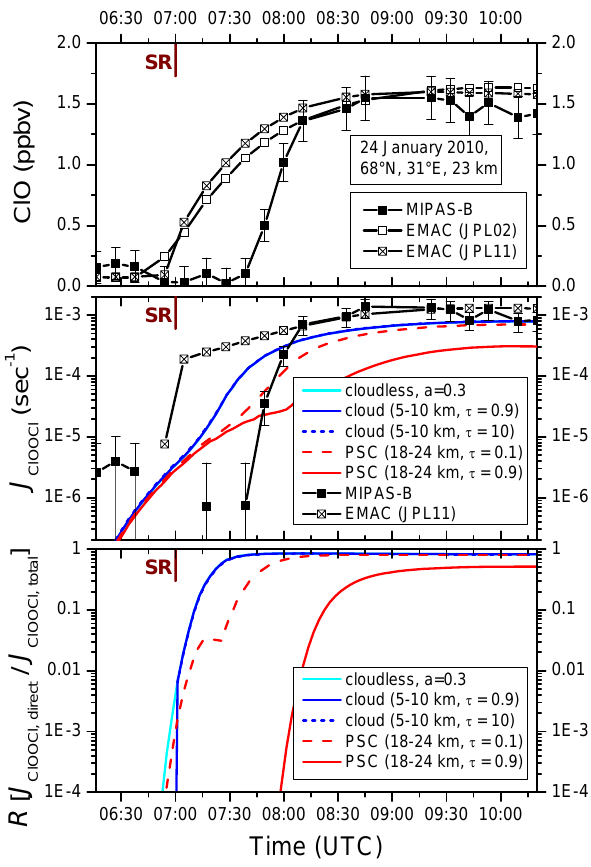
Fig. 6. Top panel: Measured and modelled build-up of ClO at 23km. ClOOCl absorption cross sections JPL02 (Sander et al., 2003) were used for the EMAC standard run. A sensitivity run was performed using new ClOOCl cross sections JPL11 (Sander et al. 2011). The delay in the observed ClO build-up is clearly visible. “SR” denotes astronomical sunrise. Middle panel: ClOOCl photolysis frequencies ( J ClOOCl ) as calculated with the TUV (version 5.0) radiation model. For cloudless conditions, a ground surface albedo of a =0.3 was assumed. Clouds in different altitudes with typical optical thick- nesses ( τ) have been taken into account (bluish curves lie close together). Photolysis frequencies from EMAC and MIPAS-B (es- timated assuming steady state, see text) are shown for comparison. While tropospheric clouds have no significant influence on the pho- tolysis rate, PSC strongly affect J ClOOCl . Bottom panel: Ratio R of the direct to total fraction of the ClOOCl photolysis frequency as calculated by TUV. Around sunrise, the diffuse radiation clearly dominates the ClOOCl photolysis